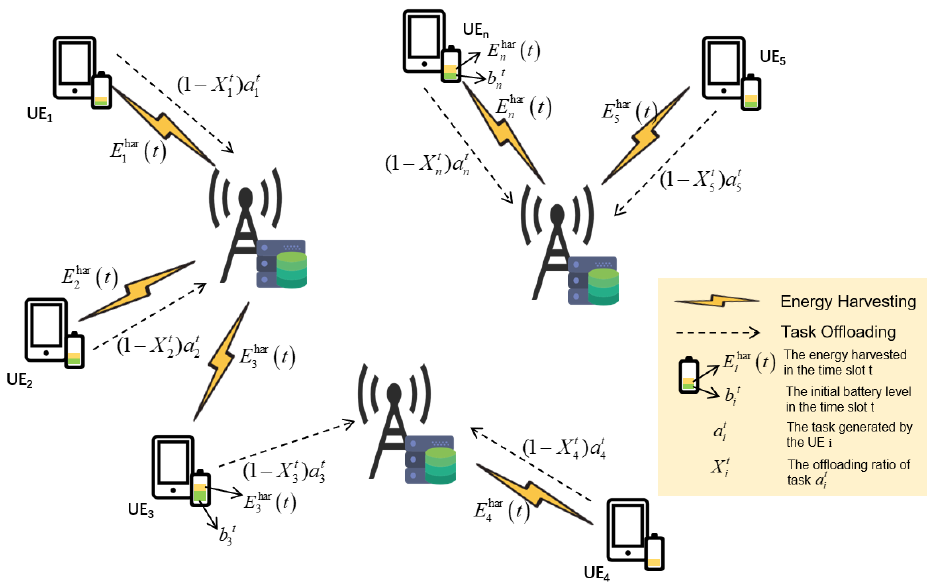
Figure 1. System